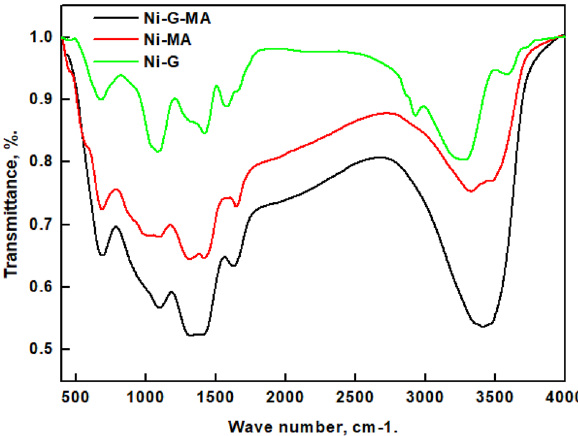
Figure 3. FTIR spectra of copper grafted by Ni-G, Ni-G-MA, and Ni-MA.